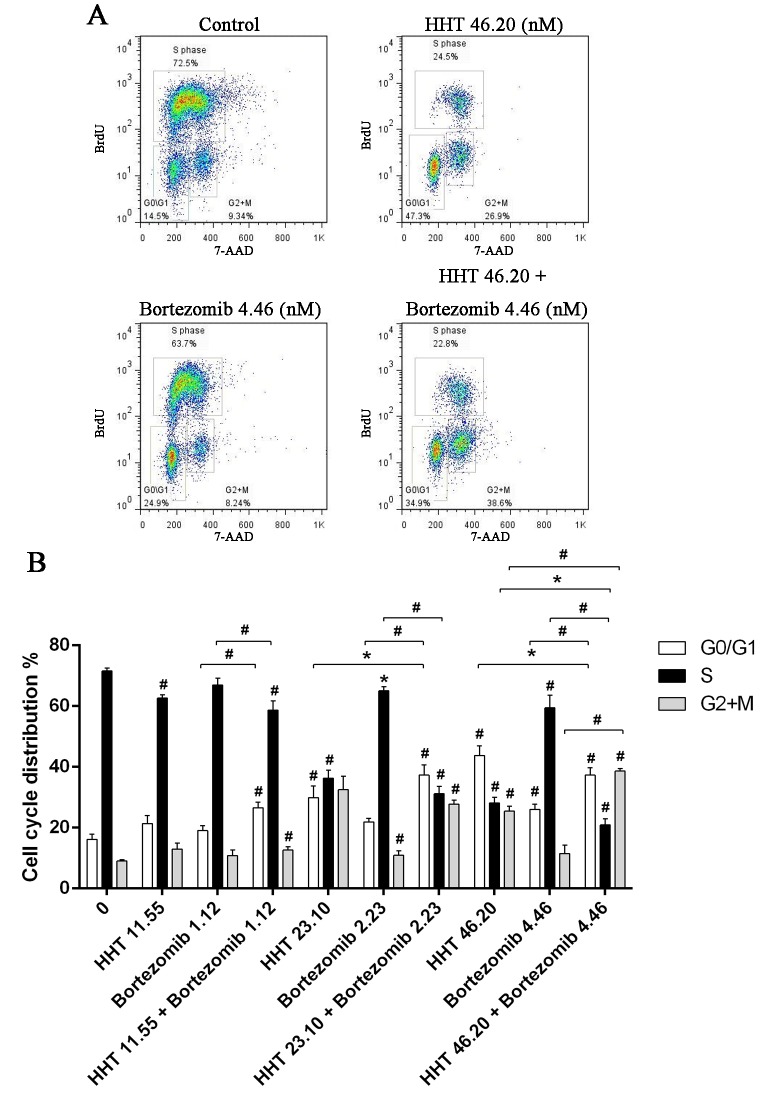
Simultaneous exposure to HHT and Bortezomib resulted in cell cycle arrest.(A) SKM-1 cells treated with 46.20 nM HHT, 4.46 nM Bortezomib or 46.20 nM HHT + 4.46 nM Bortezomib simultaneously for 72 h. (B) SKM-1 cells treated with HHT (11.55, 23.10, 46.20 nM) or Bortezomib (1.12, 2.23, 4.46 nM) for 72 h. Concurrently, simultaneous treatment experiments were conducted at molar ratio of 10.4: 1. Bar graph of cell cycle distribution. *P < 0.05, #P < 0.01 vs untreated control.